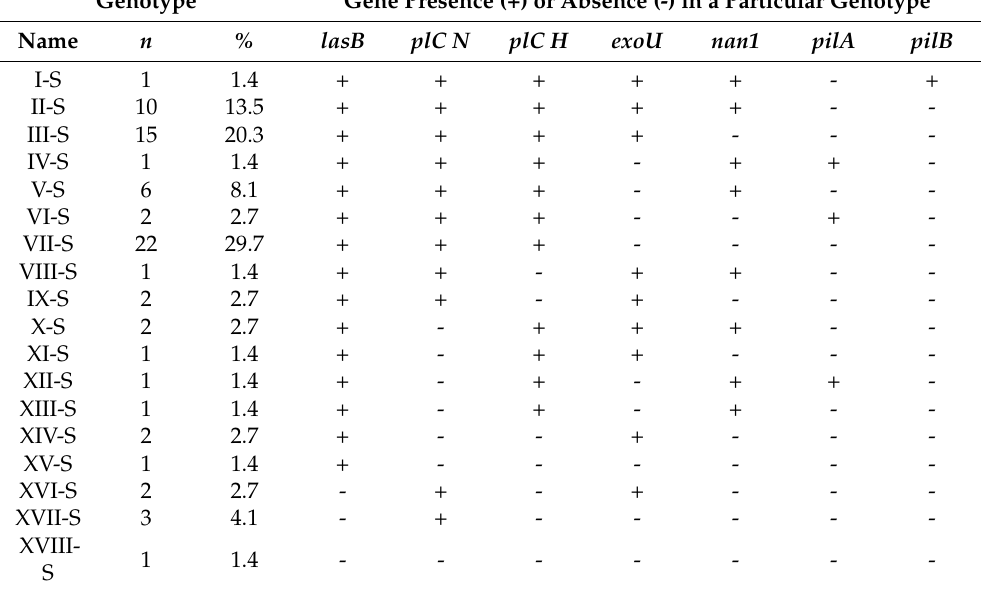
Table 1. Characteristics and distribution of the genotypes detected amongst the examined multidrug- sensitive P. aeruginosa strains ( n = 74).